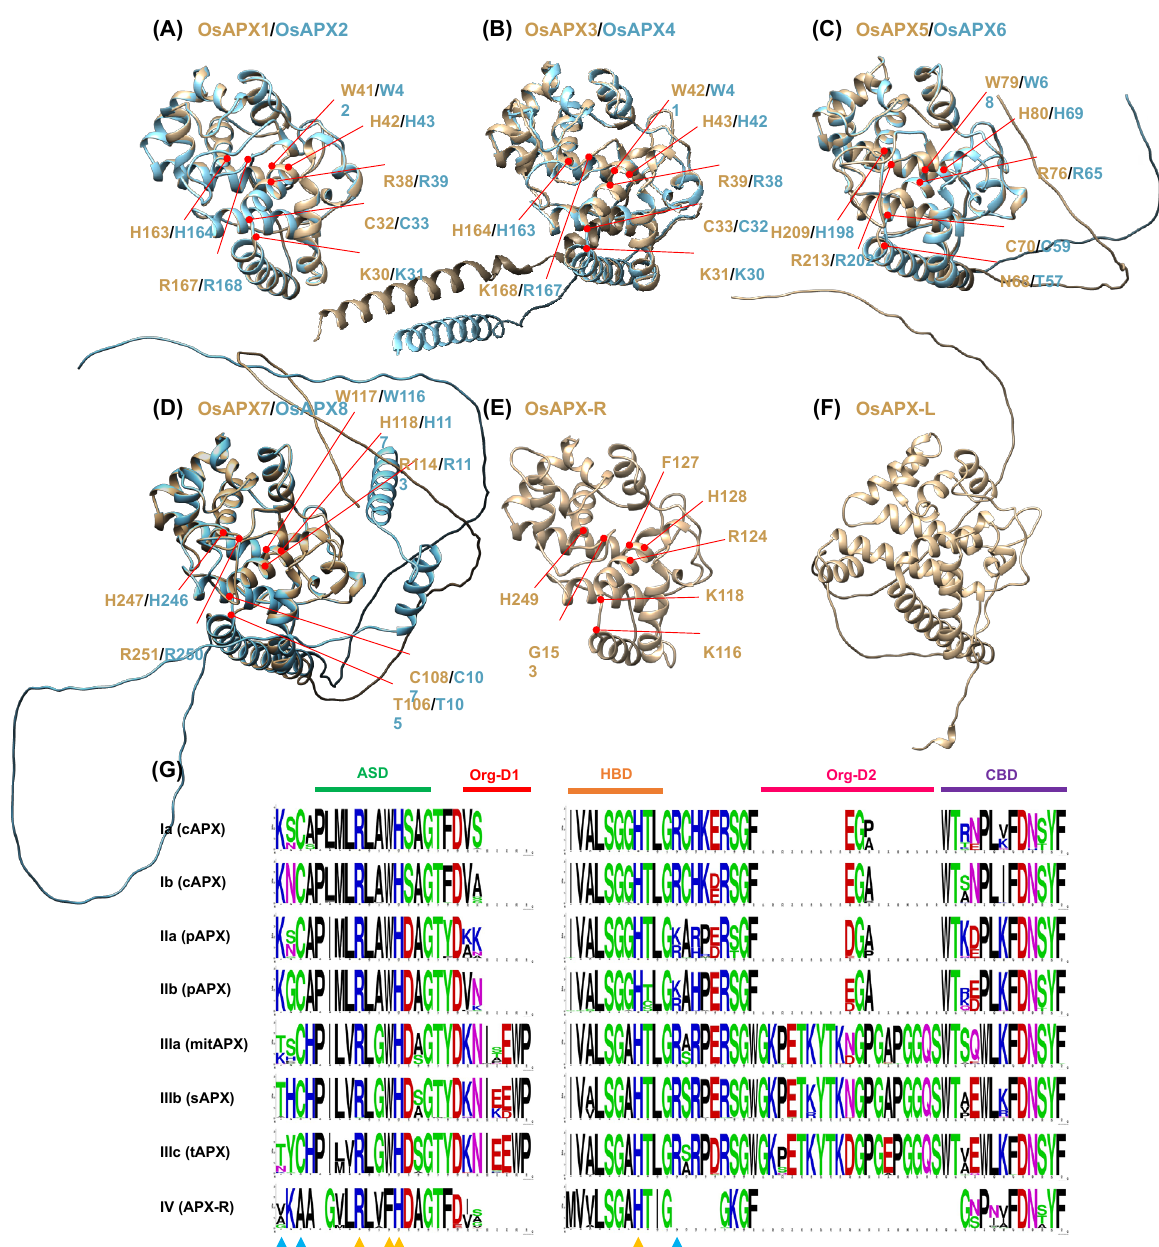
Figure 6 – Structure and protein sequence analysis of APX, APX-R and APX-L in Poaceae species. The tertiary structure of OsAPX1 and OsAPX2 (cAPX) (A) , OsAPX3 and OsAPX4 (pAPX) (B) , OsAPX5 and OsAPX6 (mitAPX) (C) , OsAPX7 and OsAPX8 (chlAPX) (D) , OsAPX-R (E) and OsAPX-L (F) was predicted by AlphaFold algorithm. The amino acid residues involved in ascorbate bind and catalytic activity are indicated. (G) Multiple sequence alignments of protein sequences. Green, red, orange, pink and purple bars represent the active site domain (ASD), organellar signature domain 1 (Org-D1), heme-binding domain (HBD), organellar signature domain 2 (Org-D2) and cation binding domain (CBD) present in all phylogenetic groups. Blue triangles represent the amino acid residues involved in ascorbate bind residues (Lys, Cys and Arg) and yellow triangles represent catalytic residues (Arg, Trp, His,